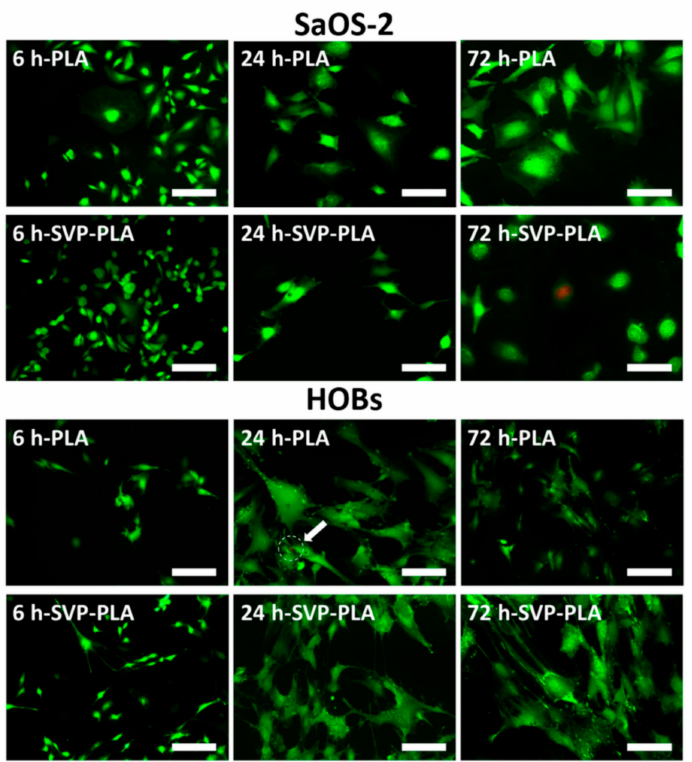
Figure 6. Fluorescence imaging of SaOS-2 cells and HOBs on neat PLA and SVP-PLA composite at 6 h, 24 h, and 72 h culturing time (Scale bars: 200 µ m). The results have shown in general lower density of SaSO-2 cells on SVP-PLA patches as compared to the PLA group, which also decreases over time. Besides that, scattered dead bacteria were present on SVP-PLA patches after 72 h. In contrast, a shift to a higher viability of osteoblasts with time could be seen in the SVP-PLA